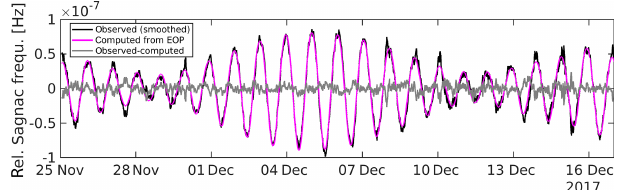
Figure 2. Relative Sagnac frequency from ring laser and computed from Earth orientation